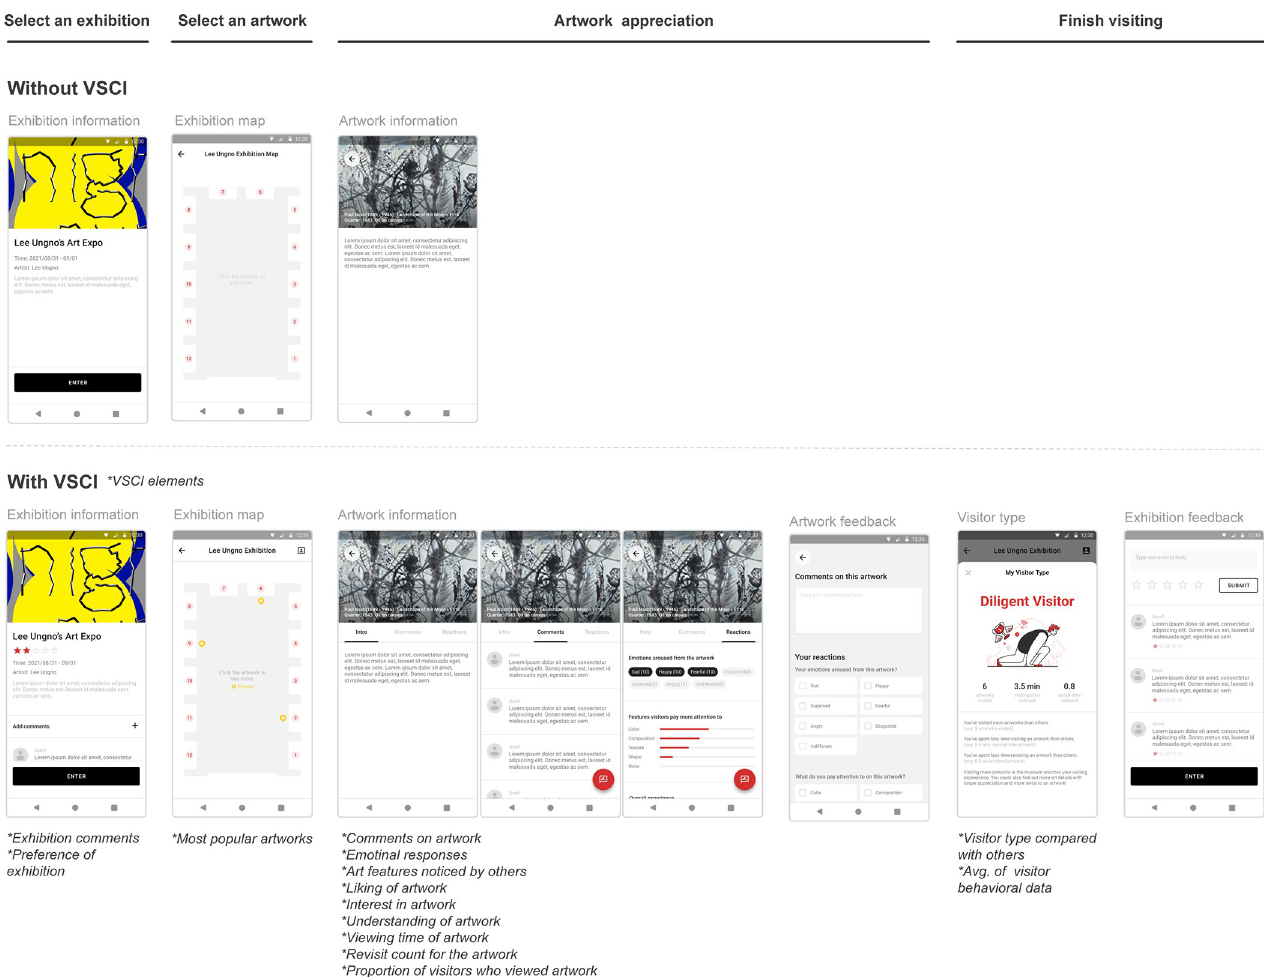
Fig 6. Prototype of mobile guidance applications (two types of apps: With VSCI and without VSCI). VSCI represents “visitor-based social contextual information”.